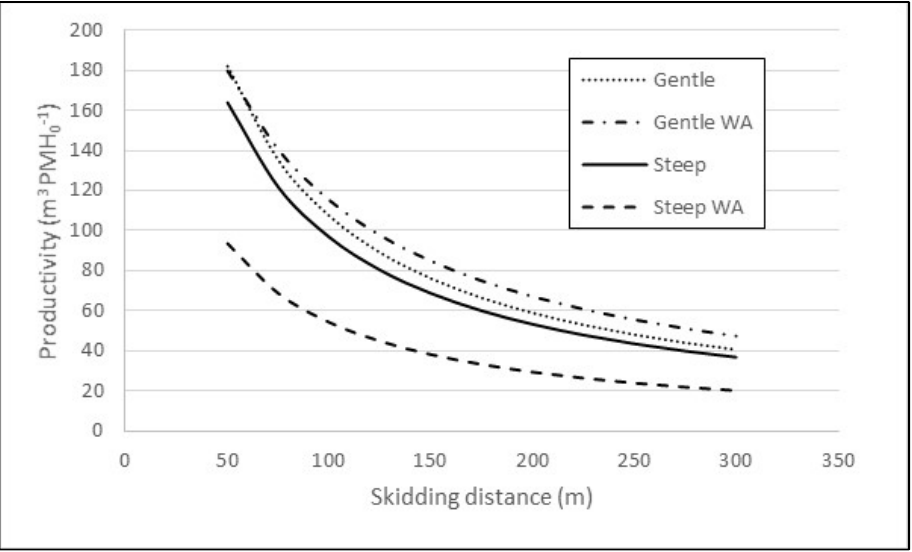
Figure 3. Delay-free productivity as a function of distance, slope gradient and winch assistance. With the skidder being tracked by a GPS unit on trail A, detailed information on its speed could be calculated at 2–5 s intervals, or approximately 15 and 30 times per trip.